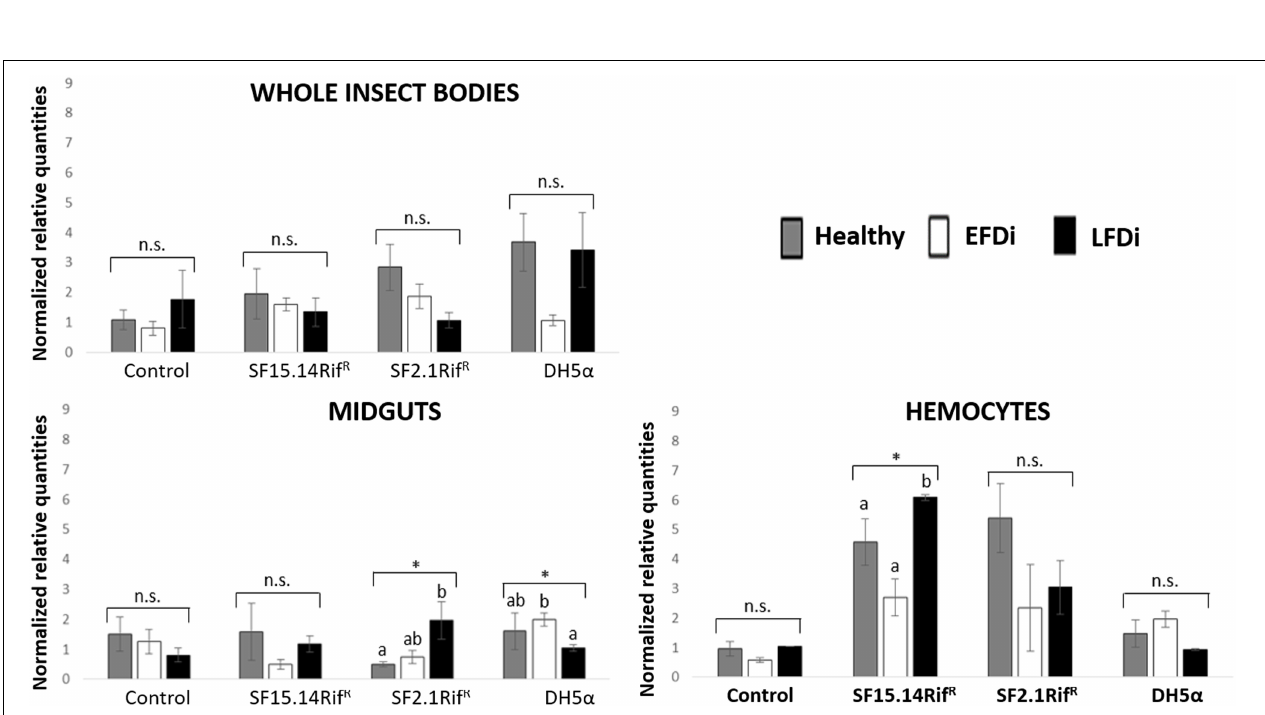
FIGURE 6 | Temporal trend of gene expression for kazal type 1 serine protease inhibitor gene. Normalized relative quantities are displayed for whole insect bodies, midgut sections, and cultured hemocytes of insects treated with Asaia SF15.14Rif R , Asaia SF2.1Rif R , and E. coli DH5 α pKan(DsRed), along with the control. Healthy: time 0 of FDp infection; EFDi time 0 + 5 days of FDp infection; LFDi: time 0 + 21 days of FDp infection. Asterisks show significant differences according to ANOVA ( P < 0.05); different letters indicate significantly different values according to Tukey’s test (a < b). DH5 α : E. coli DH5 α pKan(DsRed); n.s., not significant.